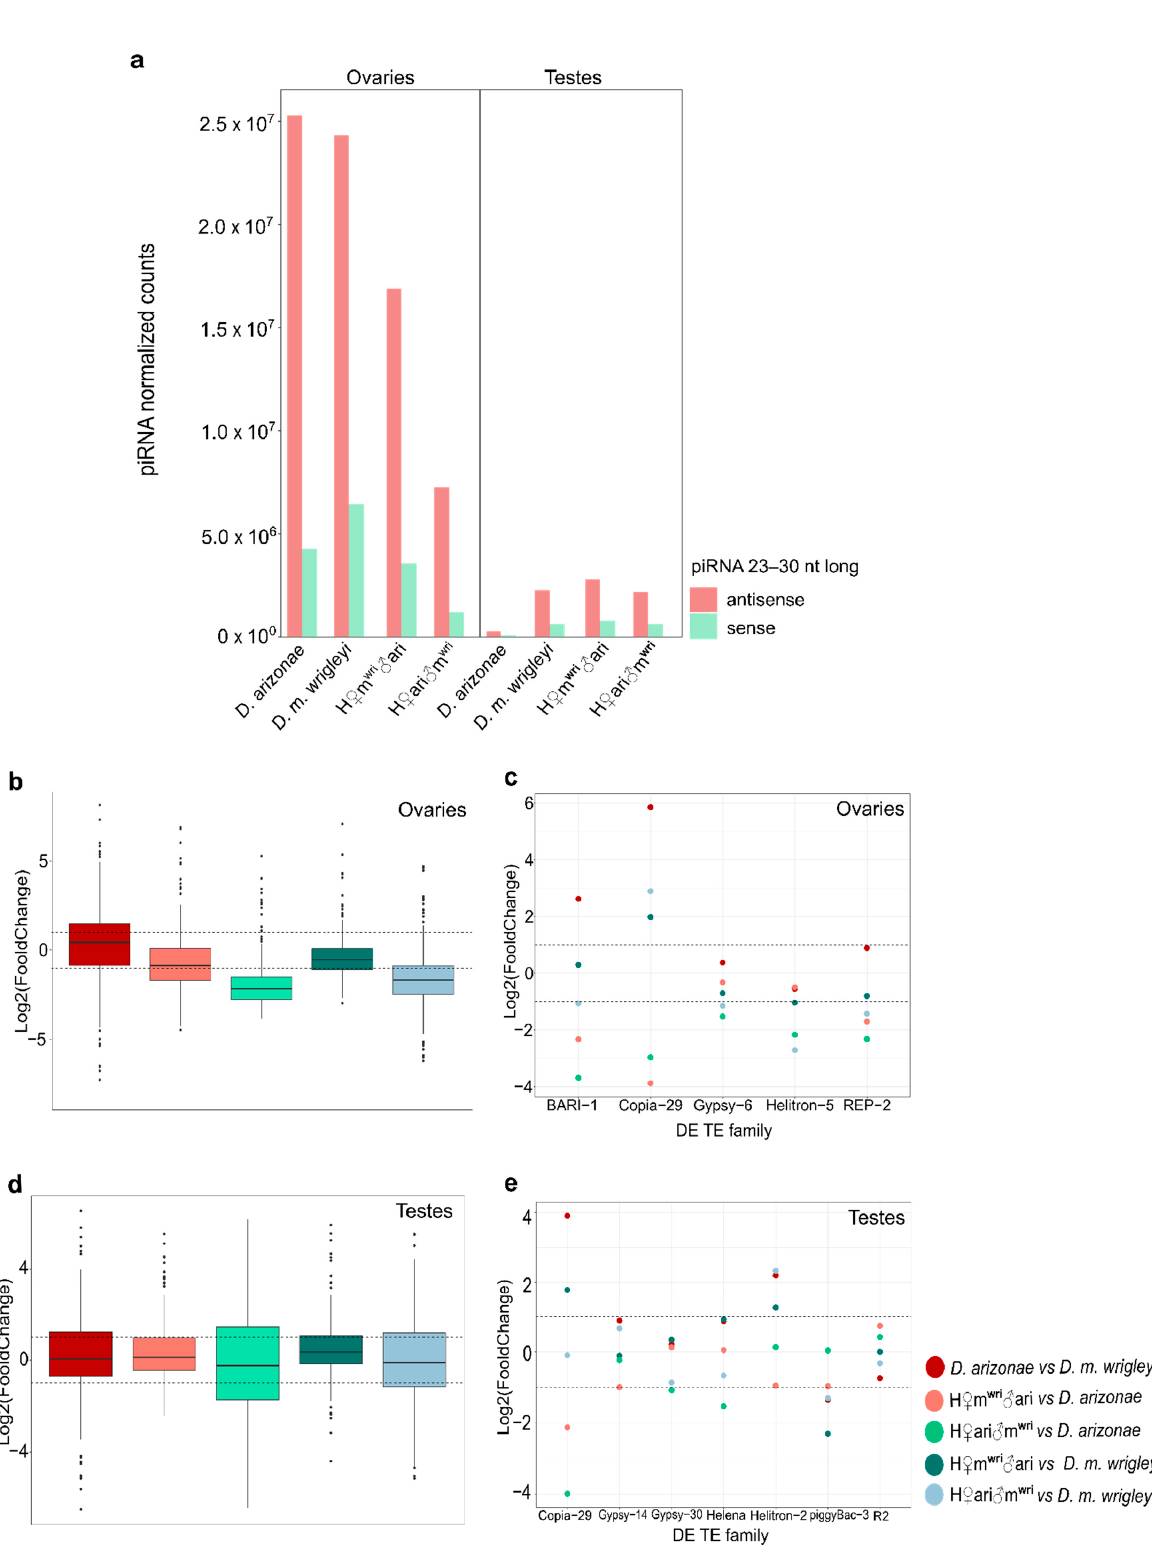
Figure 5. Small RNA abundance in gonads of hybrid and parental lines. ( a ) TE-derived small RNA production for ovaries (left) and testes (right) of D. arizonae , D. m. wrigleyi , and their reciprocal hybrids; ( b ) TE-derived 23 to 30 nt small RNA modulation upon interspecific hybridization in female gonadal tissues; ( c ) TE-specific piRNA abundance for upregulated TEs found in ovaries; ( d ) TE-derived 23 to 30 nt small RNA modulation upon interspecific hybridization in male gonadal tissues; ( e ) TE-specific piRNA abundance for upregulated TEs identified in testes. Small RNA amounts were normalized relative to miRNAs. Dotted lines represent Log2(FoldChange) =